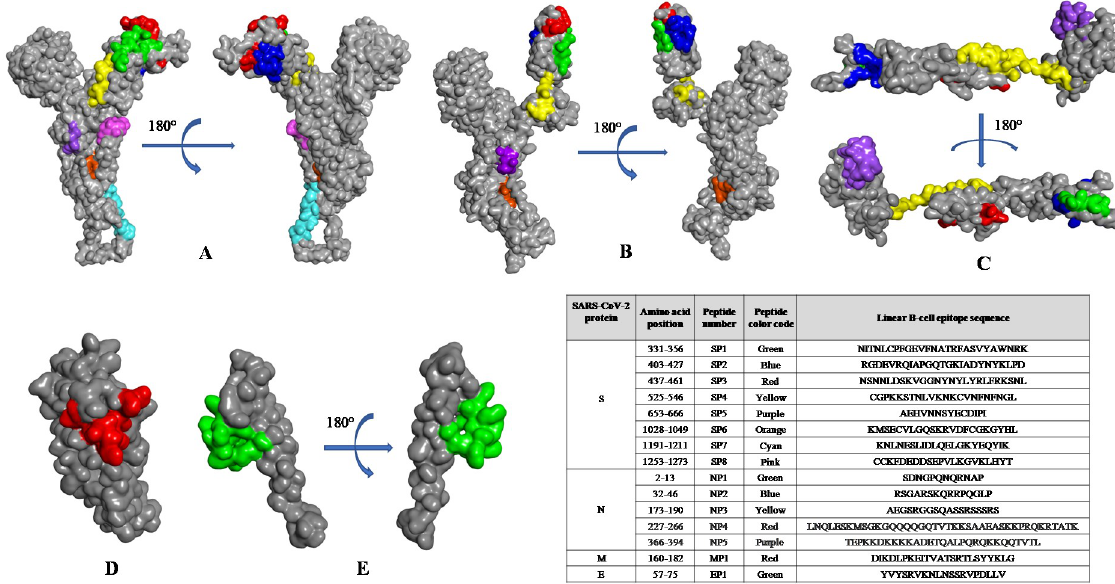
Fig 2. Mapping of linear B-cell epitopes on the three-dimensional structure of SARS-CoV-2 structural proteins. Localization of top predicted monomeric B-cell epitopes (inset table) on the (a) modeled structure and (b) crystal structure (PDB: 6VSB) of the spike protein, (c) nucleocapsid, (d) membrane, and (e) envelope proteins, as observed using BIOVIA Discovery Studio 2017 R2.